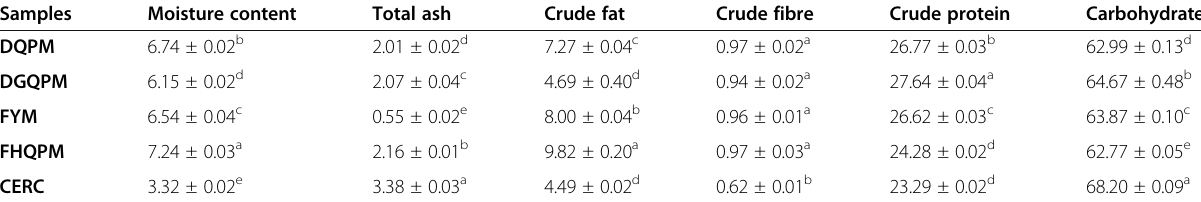
Table 1 Proximate compositions ( d.w. ) of blends of maize and almond flours (%)